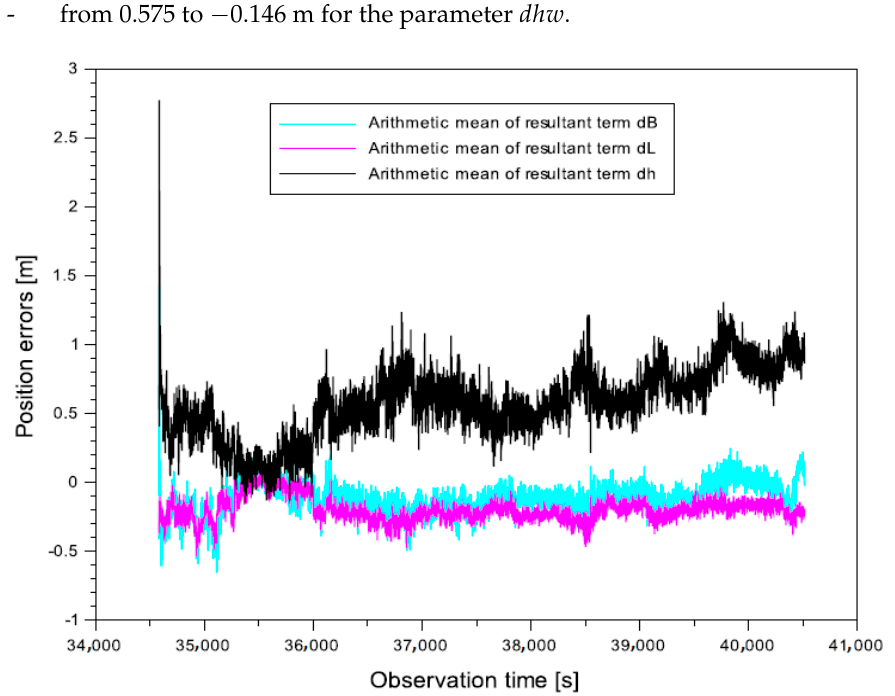
Figure 12. The arithmetic mean of parameters ( dBw , dLw , dhw )